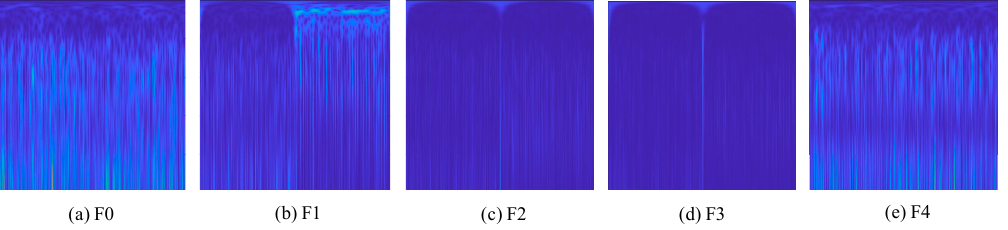
Figure 6. Signal diagrams for five different types of faults. ( a ) F0. ( b ) F1. ( c ) F2. ( d ) F3. ( e ) F4.